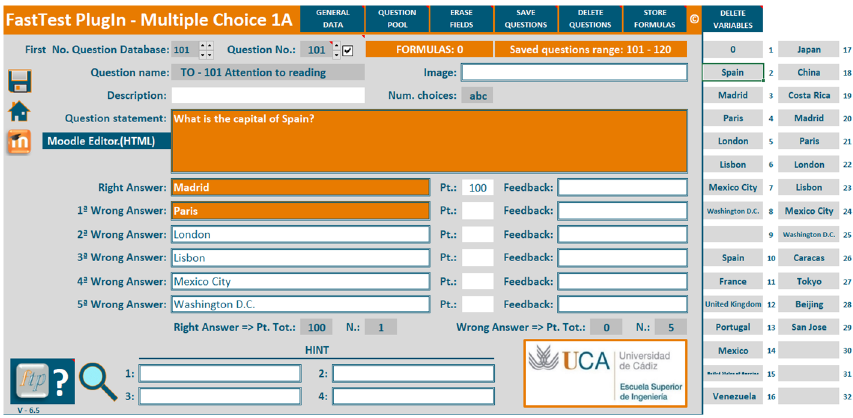
15 of 22 Figure 4. Example of a parameterised question with numerical values. The RANDBETWEEN function only accepts numerical values, and it is not possible to create parameterised questions that contain text using only this function. However, this can be done by combining other Excel functions, and there are several possible ways to achieve this.